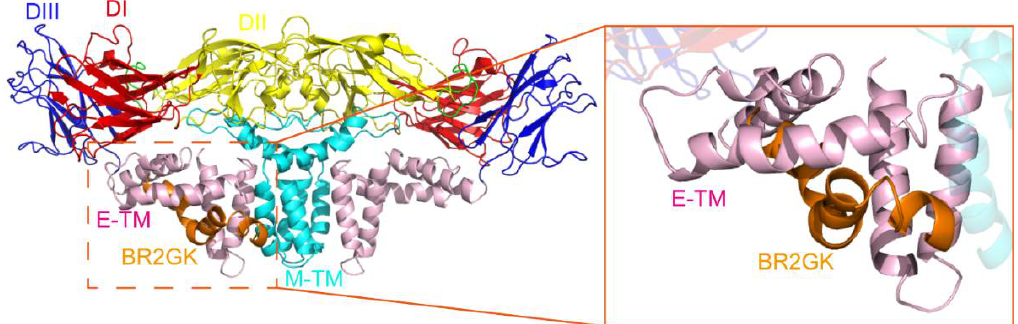
Figure 4. Molecular docking of BR2GK (orange) and ZIKV envelope protein (the domains are colored respectively). A detailed comparison of the binding site of the two structures is depicted in the zoomed view.